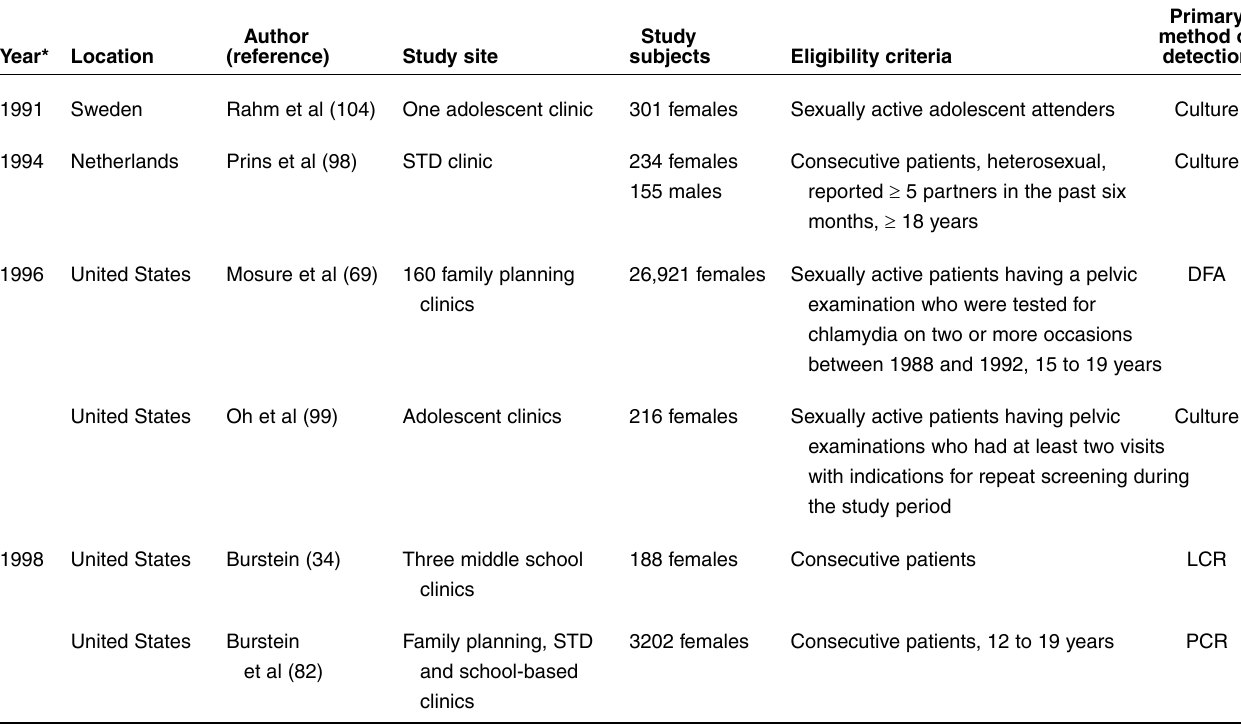
TABLE 2 Description of prospective cohort studies of